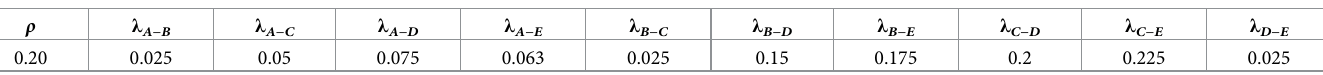
Table 4. The demand